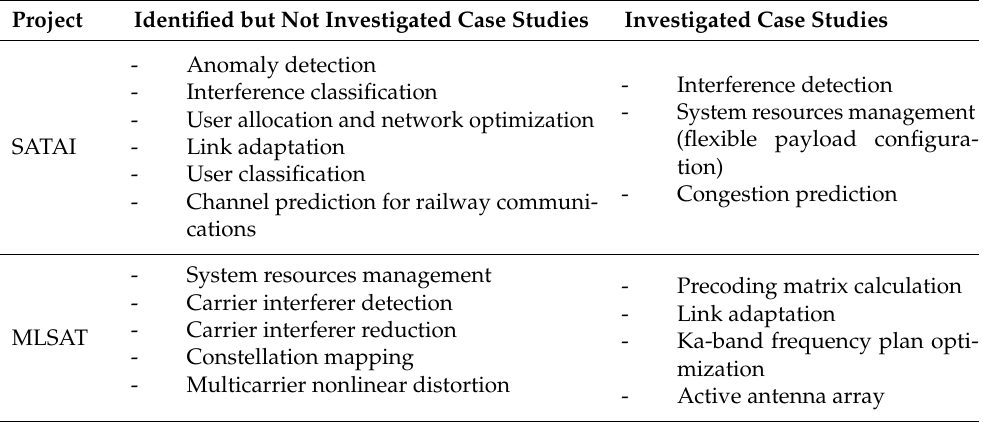
Table 1. Review of use cases considered in the SATAI and MLSAT